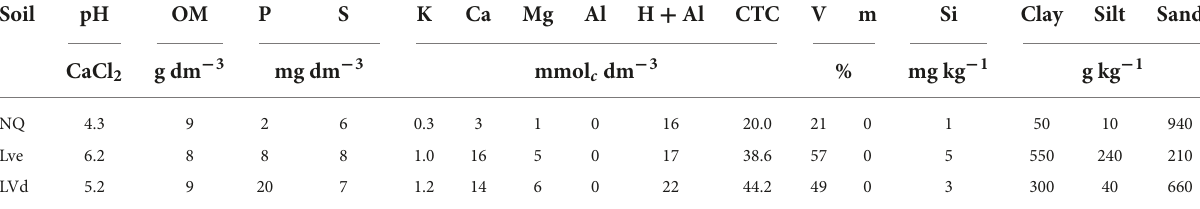
TABLE 1 Chemical characteristics of Quartzarenic Neosol (NQ), Eutroferric Red Latosol (LVe), and Dystrophic Red Latosol (LVd). Soil pH